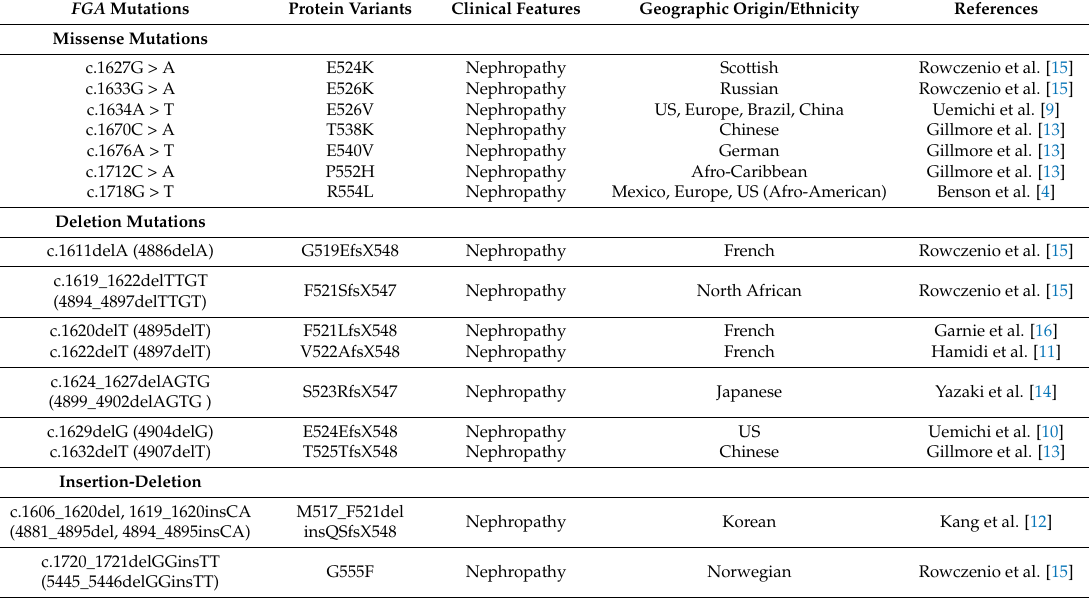
Table 1. Sixteen amyloidogenic FGA